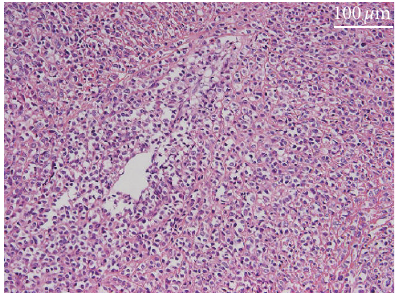
Figure 3: The specimen of the abdominal tumor excised in 2000 showing epithelioid cells arranged in an alveolar pattern,